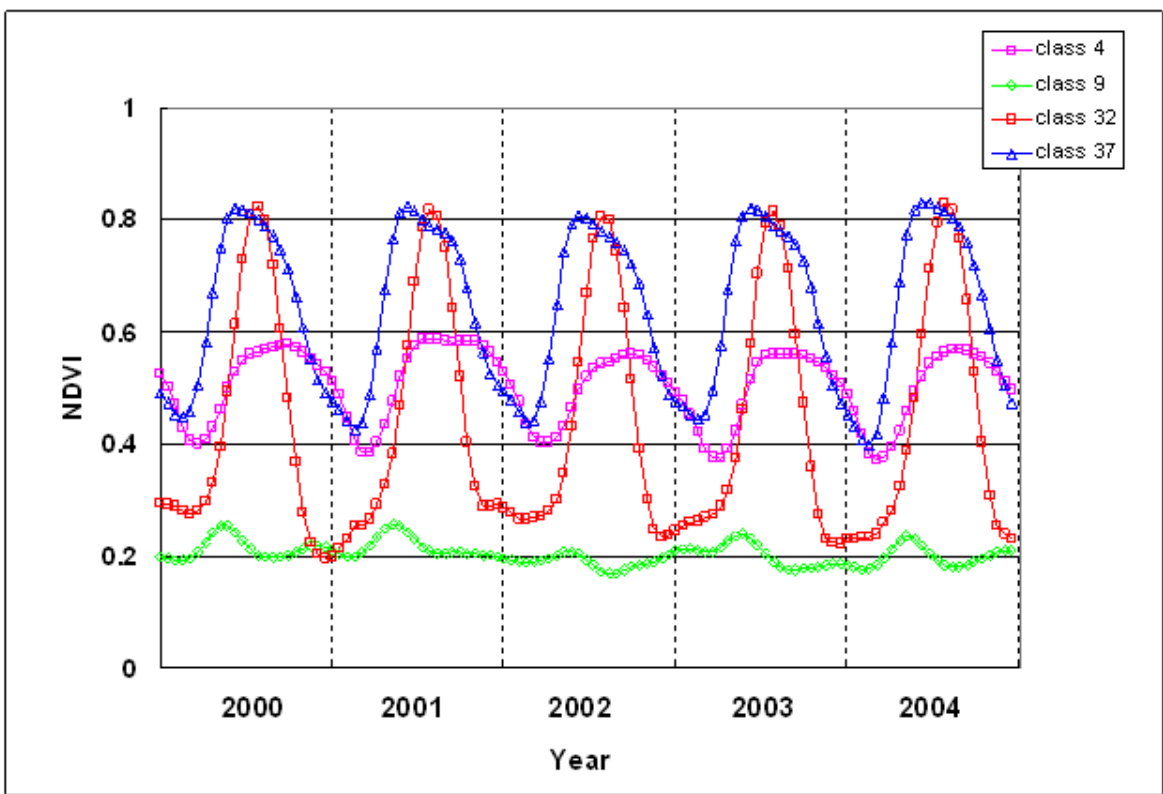
Figure 6. Multi-year seasonal NDVI time-series trajectories (2000–2004) for representative pheno-classes 4, 9, 32, and 37 (spatially averaged NDVI values) show the different phenological patterns for each